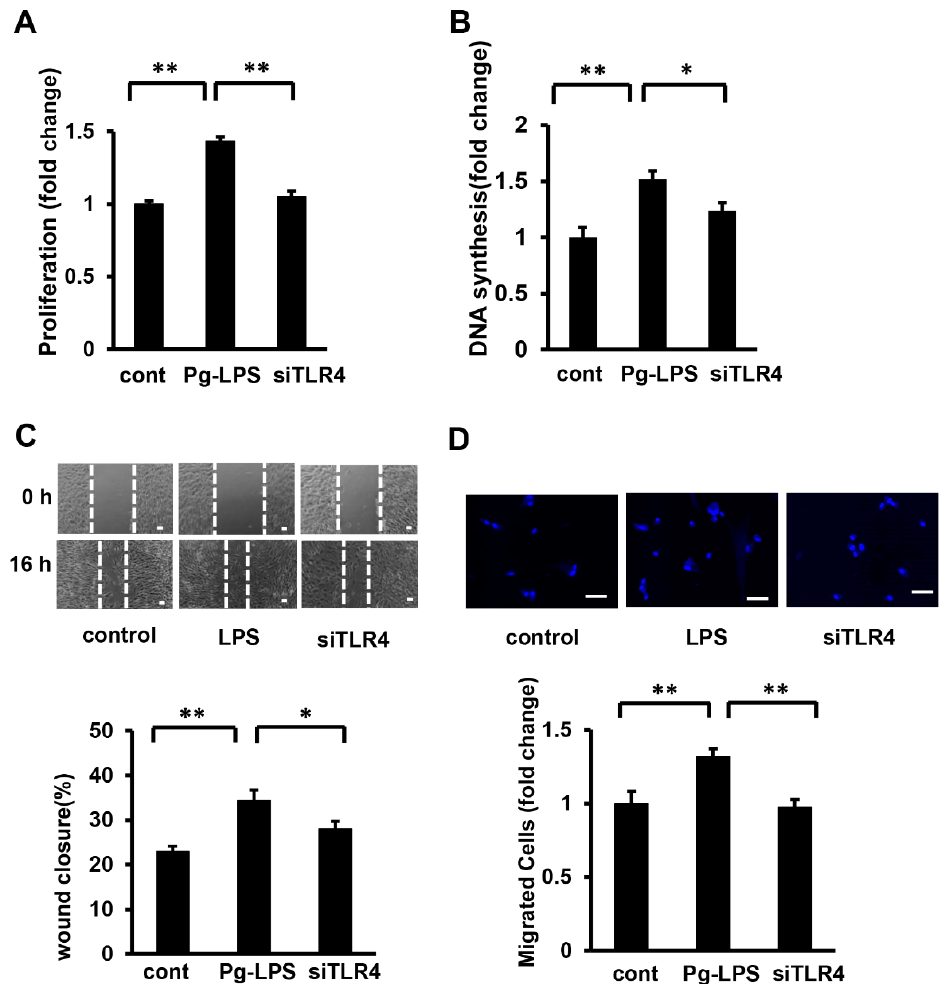
Figure 3. TLR4 knockdown attenuates the Pg -LPS induced HASMC proliferation and migration. ( A ) The effect of TLR4 knockdown on the cell number in Pg -LPS-stimulated HASMCs. TLR4 in HASMCs was knocked down (siRNA at 5 nM), and cells were stimulated with Pg -LPS (100 ng/mL) for 16 h and evaluated using the MTT assay. n = 6 in each group. ( B ) The effect of TLR4 knockdown on DNA synthesis in Pg -LPS-stimulated HASMCs. TLR4 in HASMCs was knocked down (siRNA at 5 nM), and cells were stimulated with Pg -LPS (100 ng/mL) for 16 h. Cells were labeled with BrdU for 16 h. n = 7 in each group. ( C ) The effect of TLR4 knockdown on the migration of Pg -LPS-stimulated HASMCs. The upper panels show the representative scratch wound healing assay. The lower panel shows the quantitative analyses of wound closure rate. TLR4 in HASMCs was knocked down (siRNA 5 nM), and cells were directly scratched. Cells were then incubated with Pg -LPS (100 ng/mL) for 16 h. n = 5 in each group. The scale bar shows 100 μ m. ( D ) The effect of TLR4 knockdown on the migratory property of Pg -LPS-stimulated HASMCs. The upper panels show the representative DAPI staining of migrated cells. TLR4 in HASMCs was knocked down (siRNA 5 nM). Cells were seeded in a transwell and treated with Pg -LPS (100 ng/mL) for 16 h. n = 8 in each group. The scale bar shows 50 μ m. * p < 0.05 vs. basal; ** p < 0.01 vs. basal. Data are presented as mean ± SE.